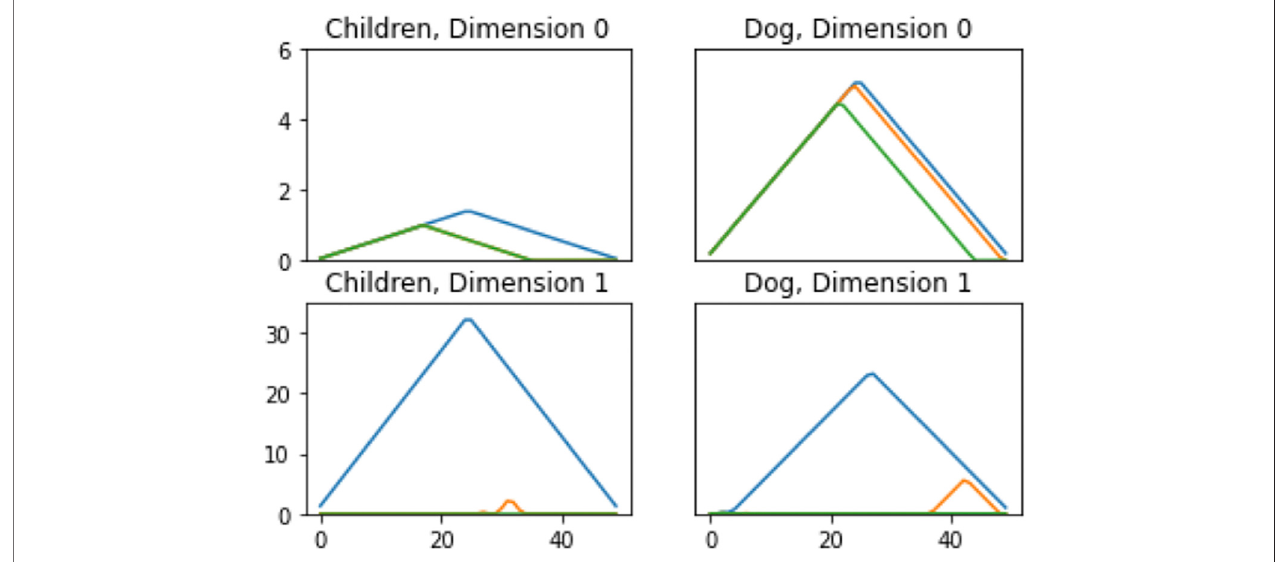
FIGURE 6 | Persistence Landscapes from the MPEG7 dataset to show differences in features. Each color corresponds to a different landscape, i.e., λ k for k (cid:1) 1 , 2 , 3.